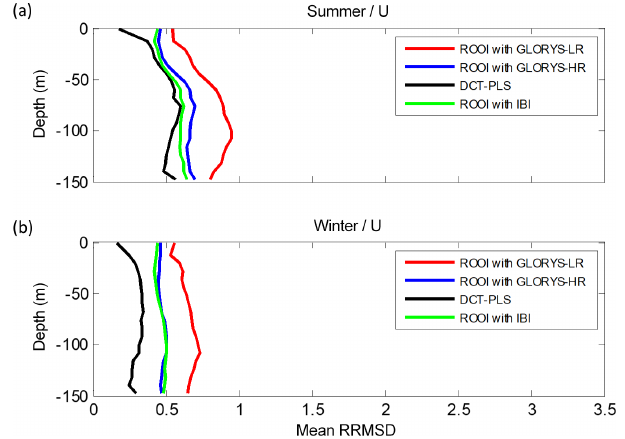
Figure 11. Mean RRMSD- U related to all the data-reconstruction methods for each depth considering the reduced grid domain for the summer period (a) and for the winter period (b)